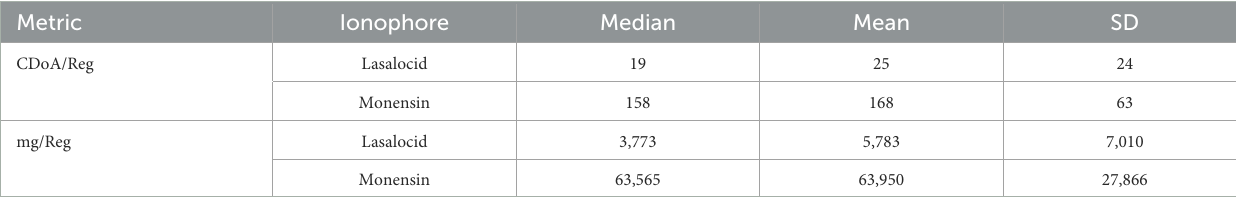
TABLE 11 Not-medically antimicrobial regimen descriptions for calendar days of administration per regimen (CDoA/Reg) and milligrams of antimicrobial per regimen (mg/Reg).